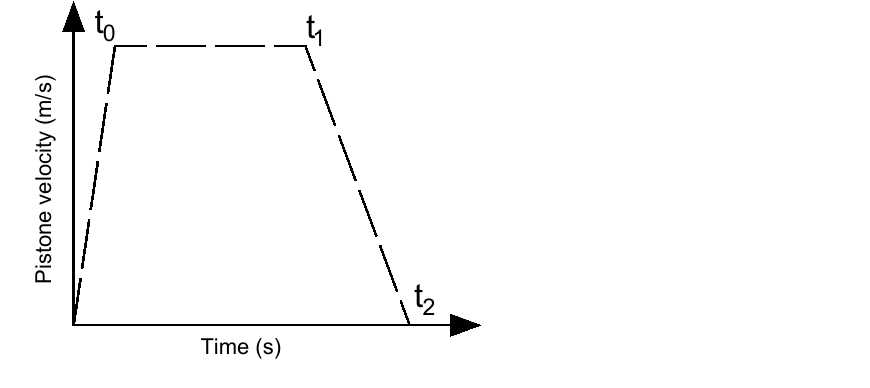
Figure 11. Typical trapezoidal variation of piston velocity (motion) with time. For a constant piston velocity ( t 0 ≤ t ≤ t 1 Solutions for the piston acceleration Equation (35) and constant piston velocity Equa- tion (36) when form an analytical solution for the ramp change of velocity. Das and Arakeri pointed out after analyzing the flow profiles for the piston deceler- 𝑡𝑡 1 → ∞ ation phase that the velocity profiles close to the walls can be in the opposite direction to the core flow. So, this type of unsteady flow does have inflection points and hence can become unstable at relatively low Reynolds numbers.